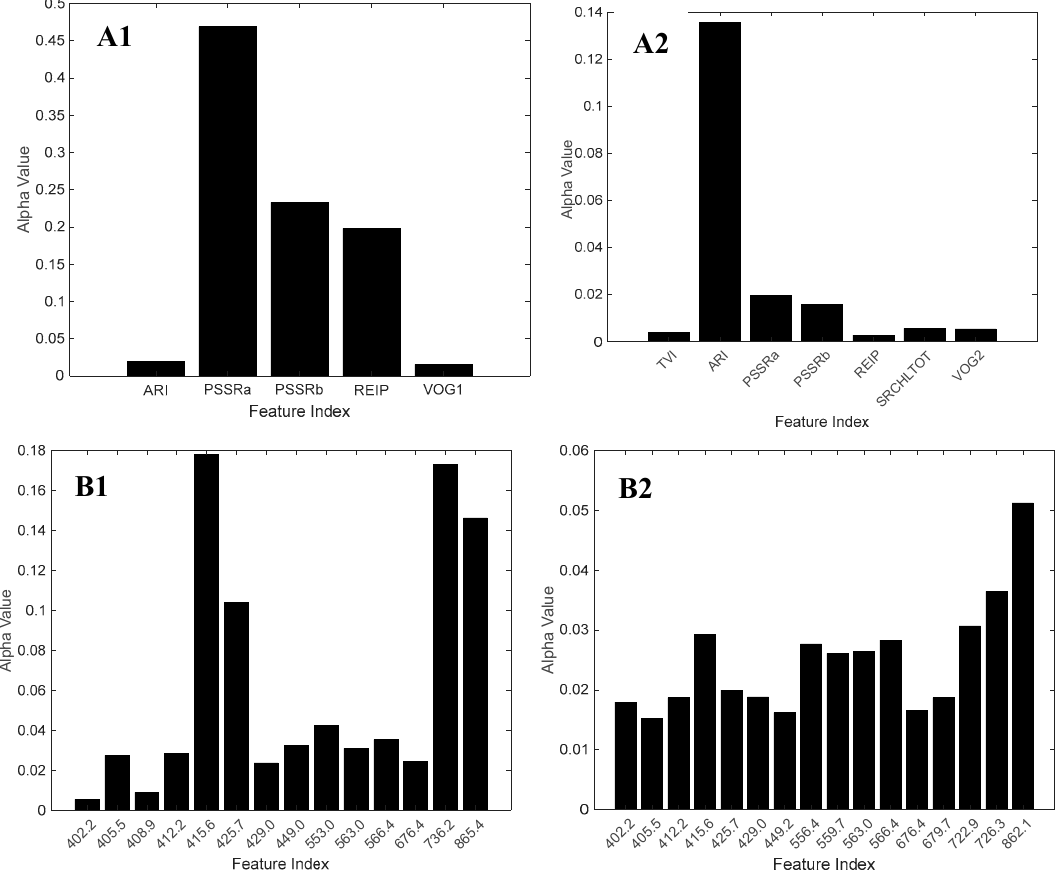
Figure 7. The alpha hyperparameter values for connected input features with the hidden layer of the trained MLP–ARD algorithm. Diagrams A1 and B1 represent the alpha values of the model before the outlier elimination and A2 and B2 the alpha values of the model after the outlier elimination. In row A ( A1 and A2 ) the models that use the VIs as input features are presented, while the respective models that use the EWs as input features are presented in row B ( B1 and B2 ).